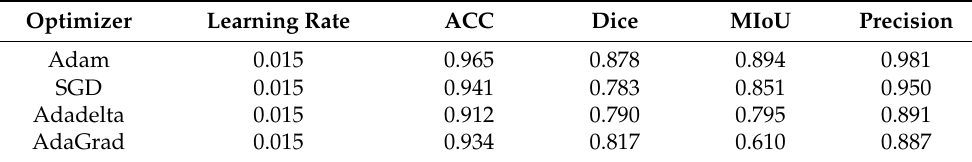
Table 2. Overall performance for different